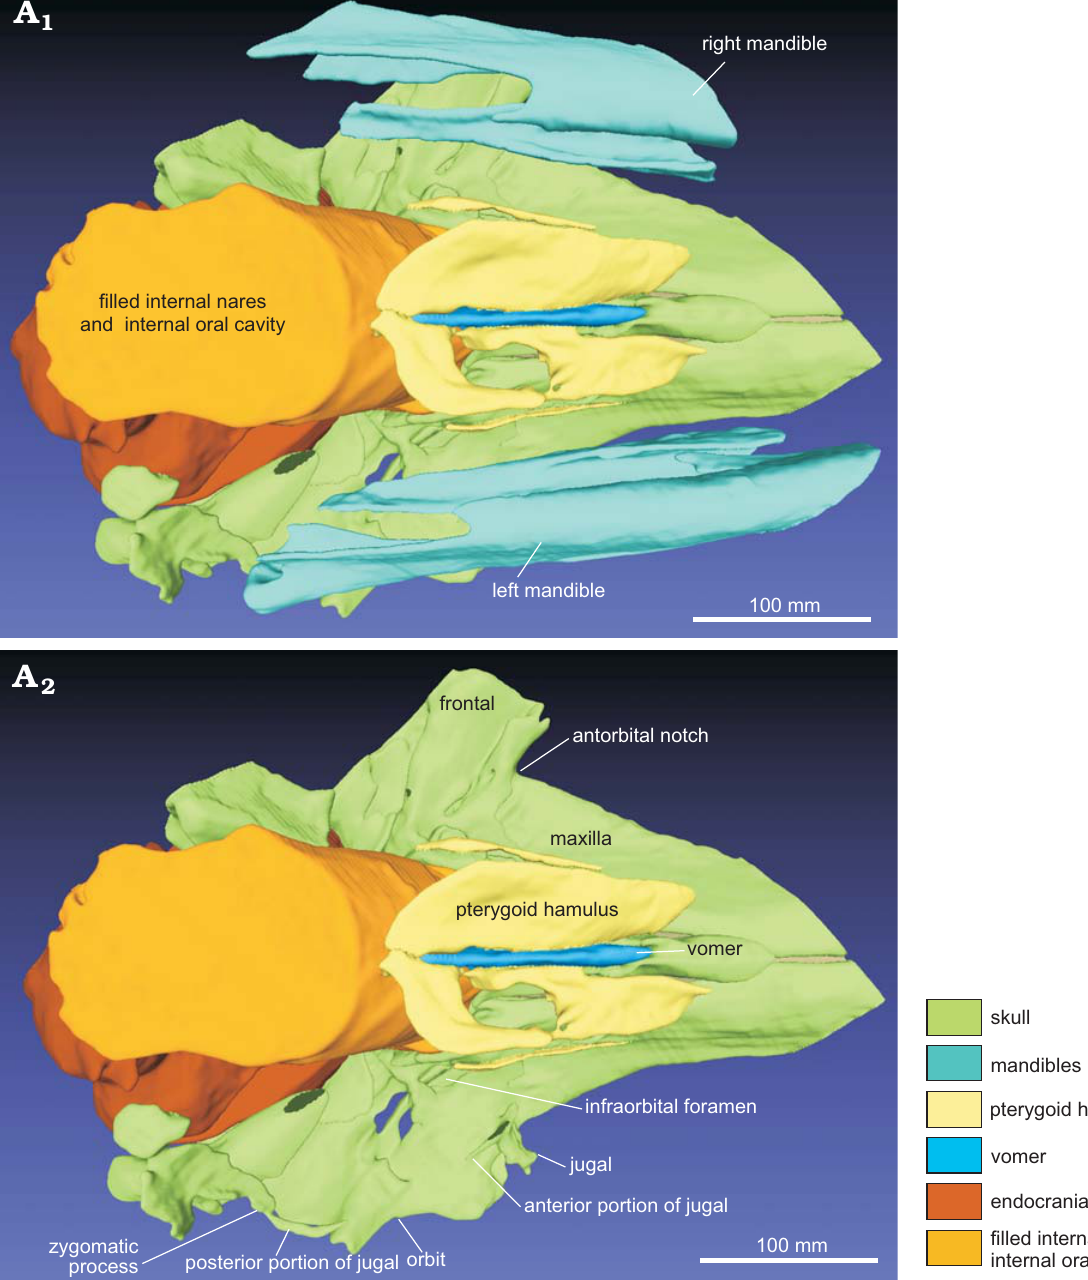
Fig. 5. 3D reconstruction resulting from the CT-scan of the ziphiid cetacean Messapicetus cf. longirostris Bianucci, Landini, and Varola, 1992 skull (MDM- 2029) inside two limestone slabs from the Tortonian of Menorca (Balearic Islands, Spain); in ventral view (A 1 ), ventral view without the mandibles (A 2